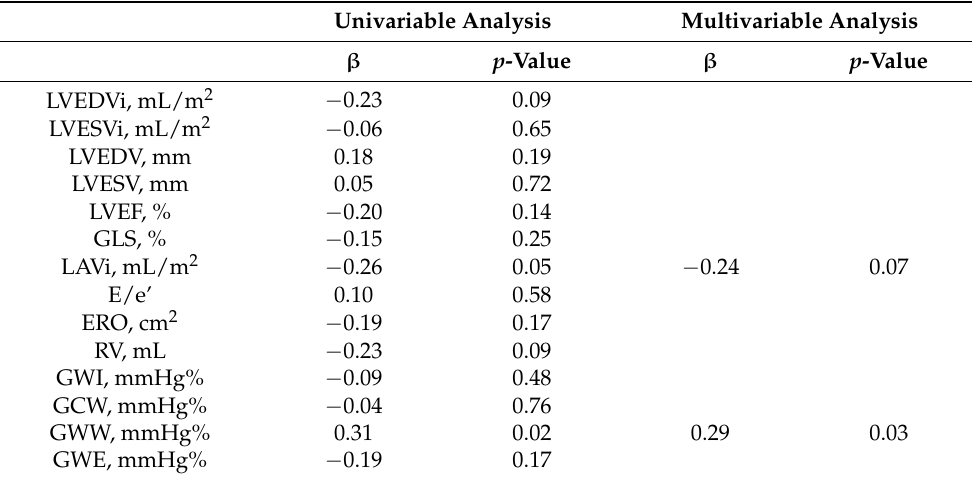
Table 4. Predictors of left ventricular reverse remodeling at 1-year